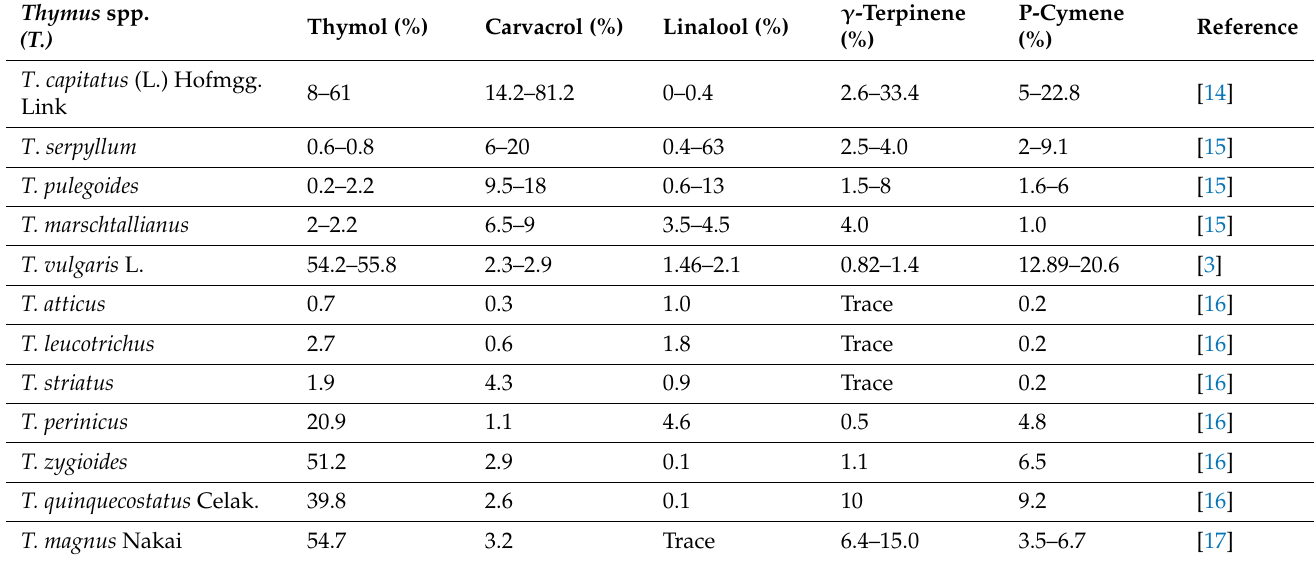
Table 1. Prevalence of main thyme oil molecular species in different thyme